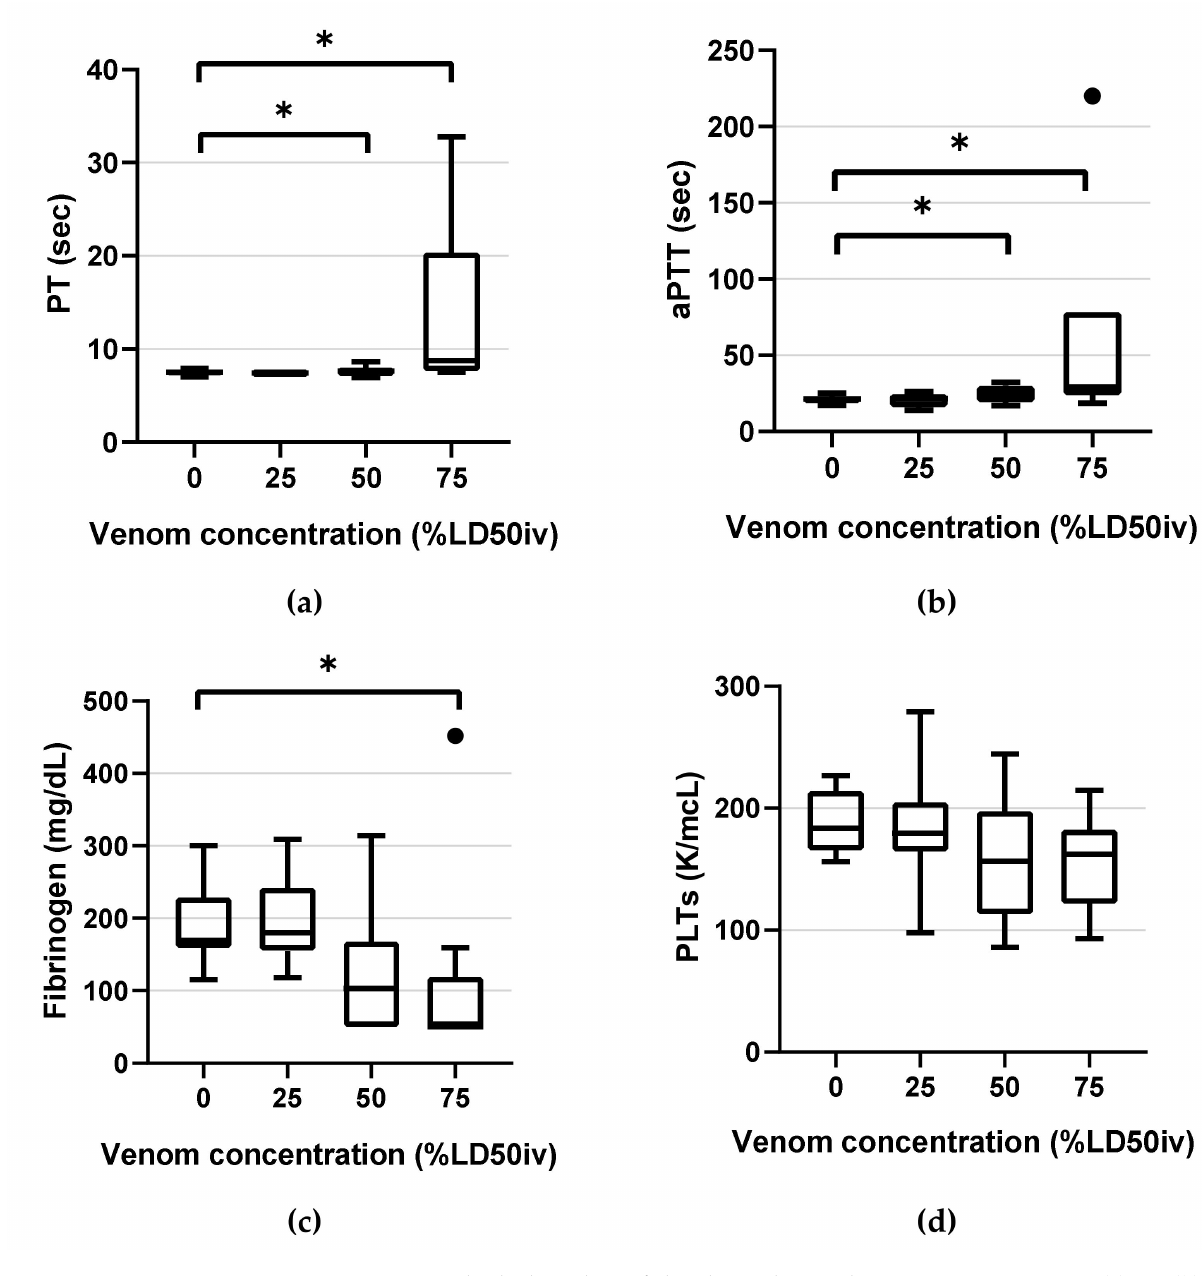
Figure 2. Box-and-whisker plots of the classical coagulation tests parameters: ( a ) PT ( b ) aPTT ( c ) fibrinogen ( d ) PLTs. Horizontal lines inside the boxes indicate the median. The upper boundary of the boxes indicates the top quartile, whereas the lower indicates the bottom quartile. An asterisk (*) indicates the venom concentration (% intravenous lethal dose 50 (LD50 iv )) displaying a significant change compared with the control ( p < 0.05). Differences between the 75th and 25th quartiles higher than 1.5-fold were considered as outliers and indicated by a black dot ( • ). PT, prothrombin time; aPTT, activated partial thromboplastin time; PLTs, platelet